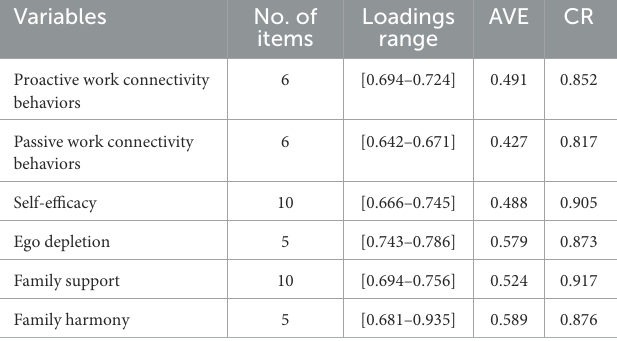
TABLE 3 Composite reliability and convergent